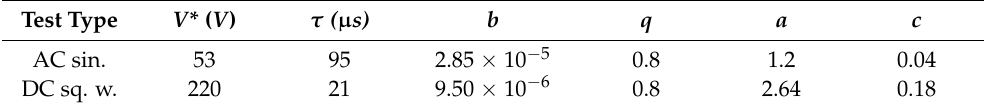
Table 1. Parameters of Khakpour model